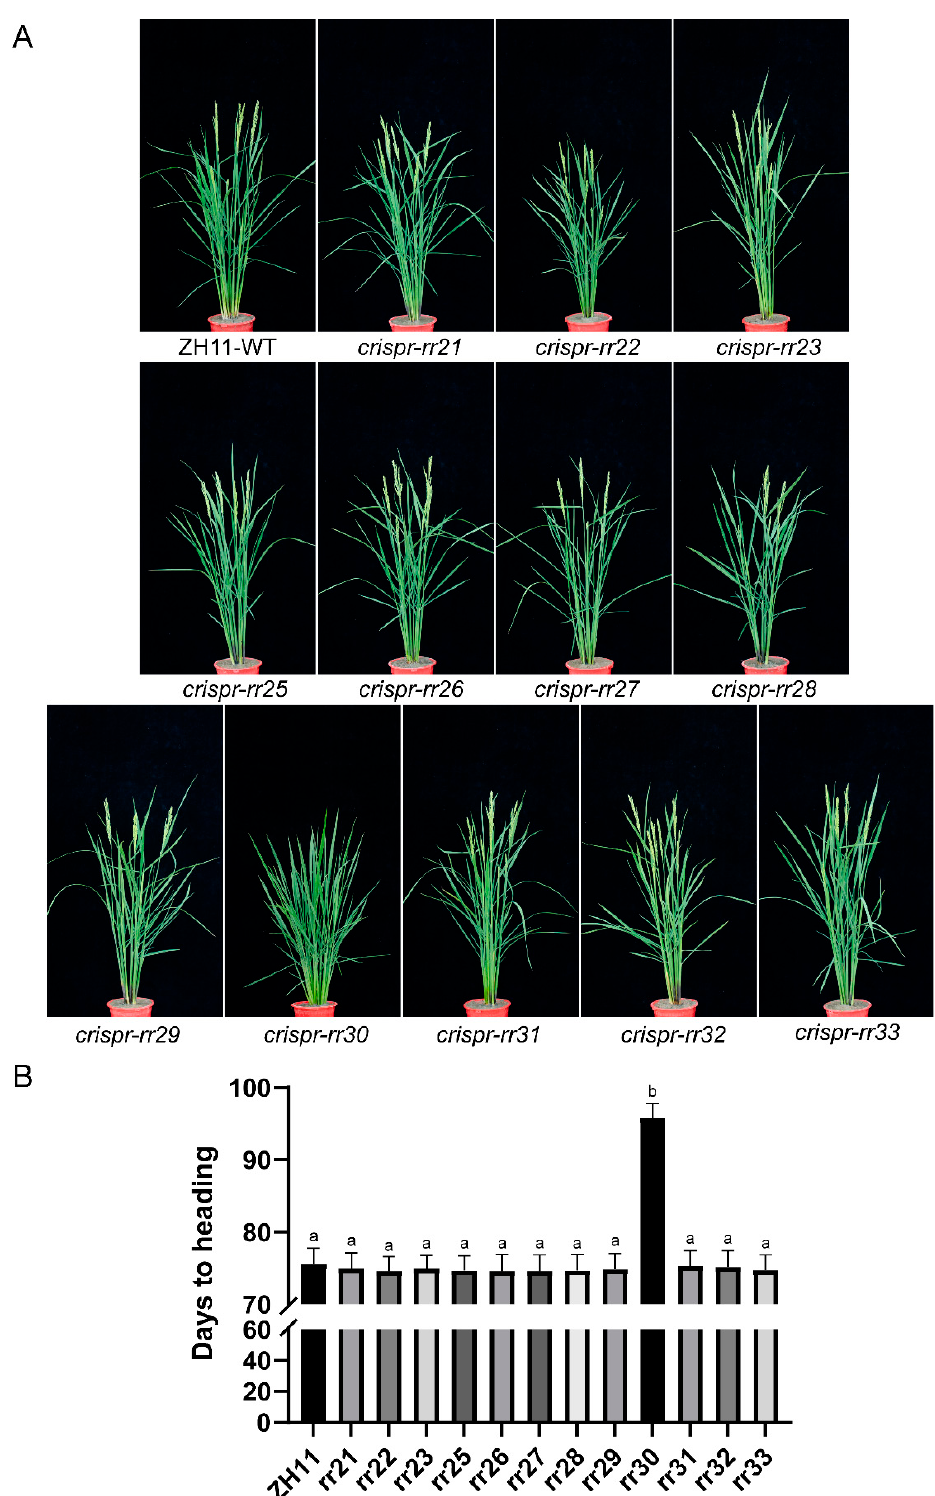
Figure 6. Heading date of type-B OsRR mutants. ( A ). Phenotypes of WT and mutants at the heading stage. ( B ). Days of heading in WT and mutants (n = 20). Values are presented as mean ± standard deviation (SD). The “a and b” respectively represent the differences determined by least significant difference (LSD) method with p = 0.05, the same letter indicates that there is no significant difference from each other.